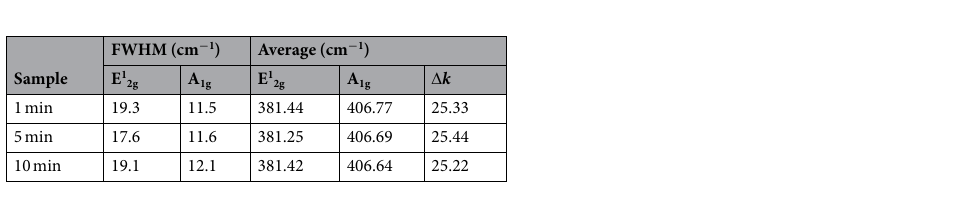
Table 1. FWHM of E 1 2g and A 1g peaks in Raman spectra (Fig. 1) and average values of E 1 2g , A 1g peak positions, and ∆ k in Raman map data (Fig. 2) for 1, 5, and 10 min EBI-treated